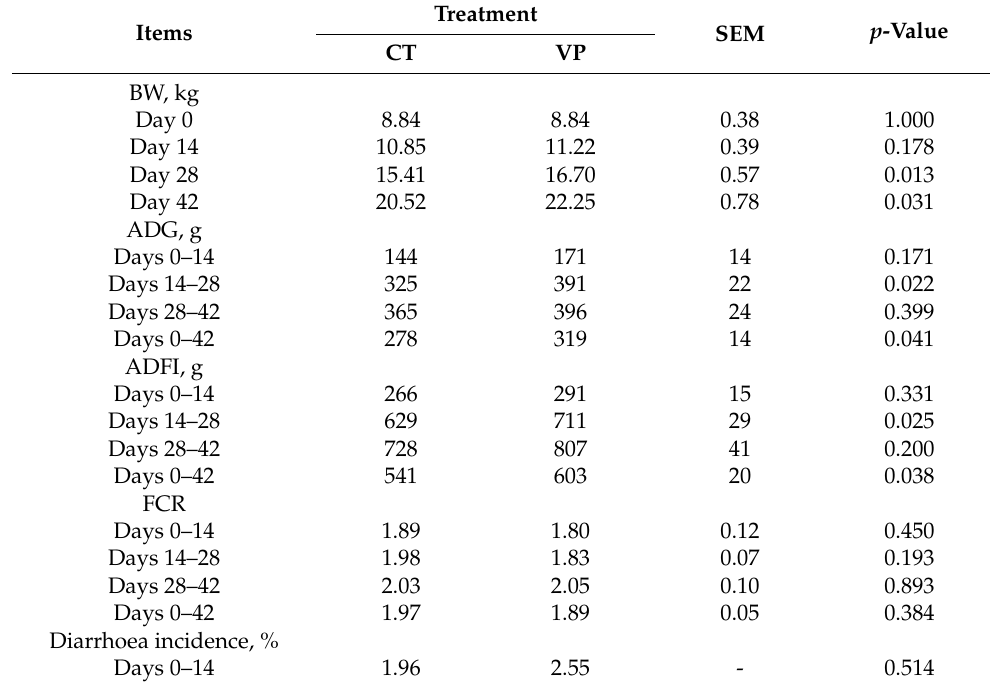
Table 2. Effect of dietary supplementation with stimbiotics on growth performance and diarrhoea incidence of weaned